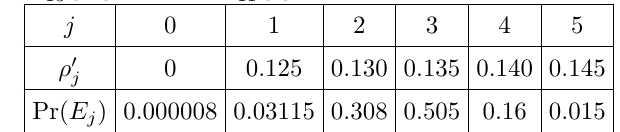
Table 6: ρ ′ values and corresponding Pr( E j ) for the bias distribution using Chosen IV j approach for ID ∆ (0) [13] and OD ∆ (3) [0] after 3 rounds 13 11 j 0